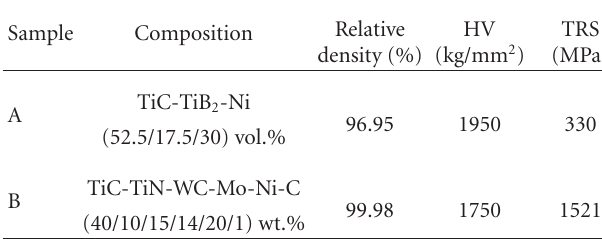
Table 1: Comparison of mechanical properties between the sample in the present work (A) and that in literature (B)